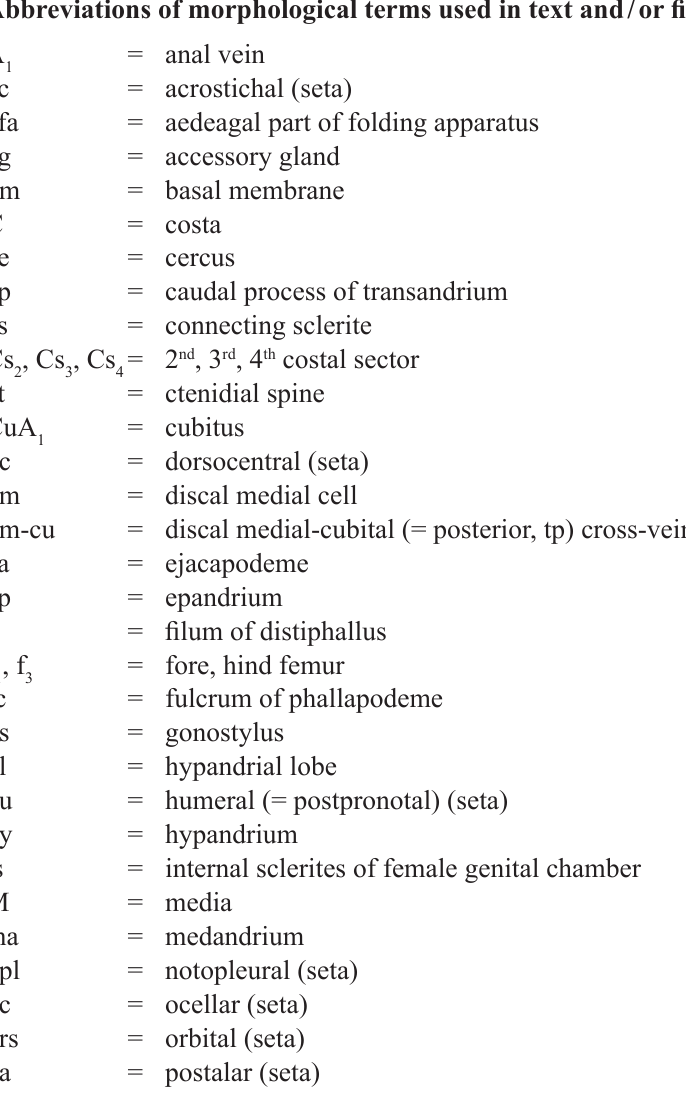
Abbreviations of morphological terms used in text and / or figures